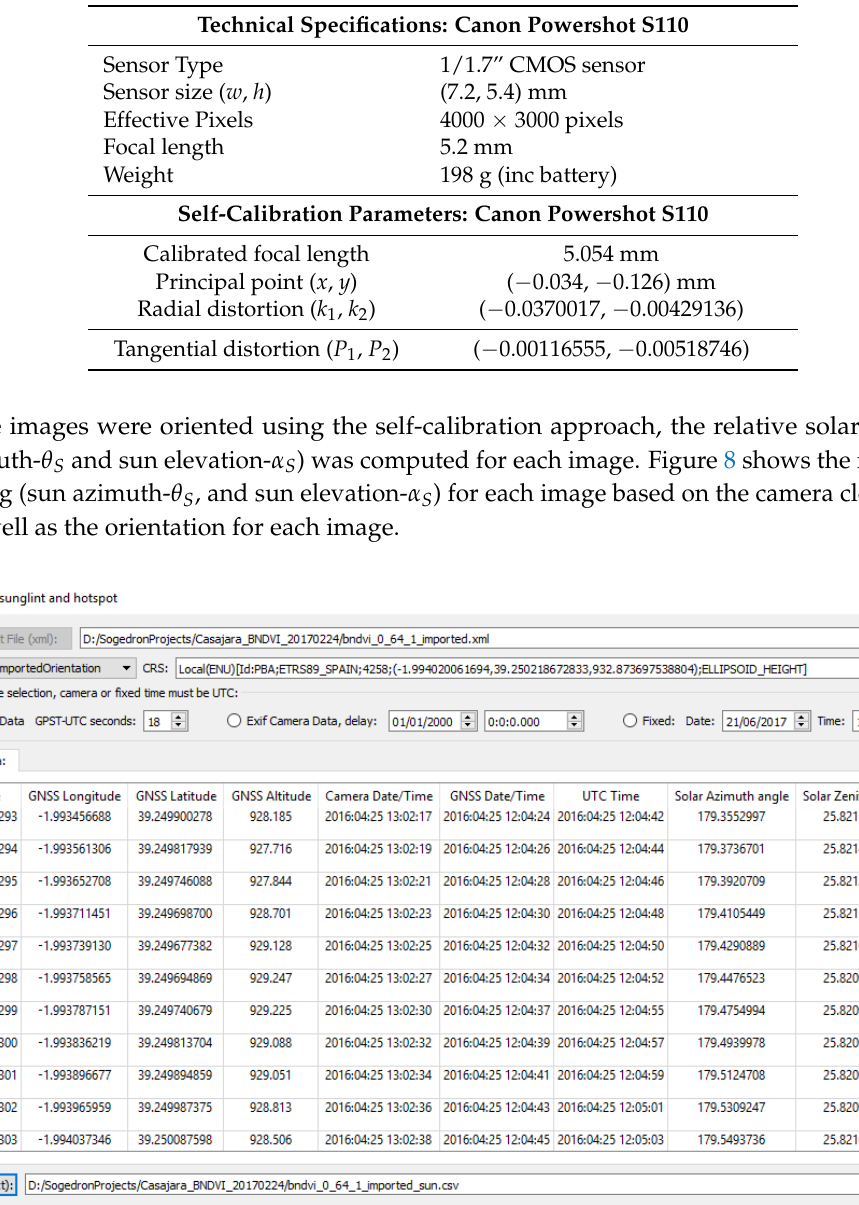
Table 2. Technical specifications and camera self-calibration parameters: Canon Powershot S110.